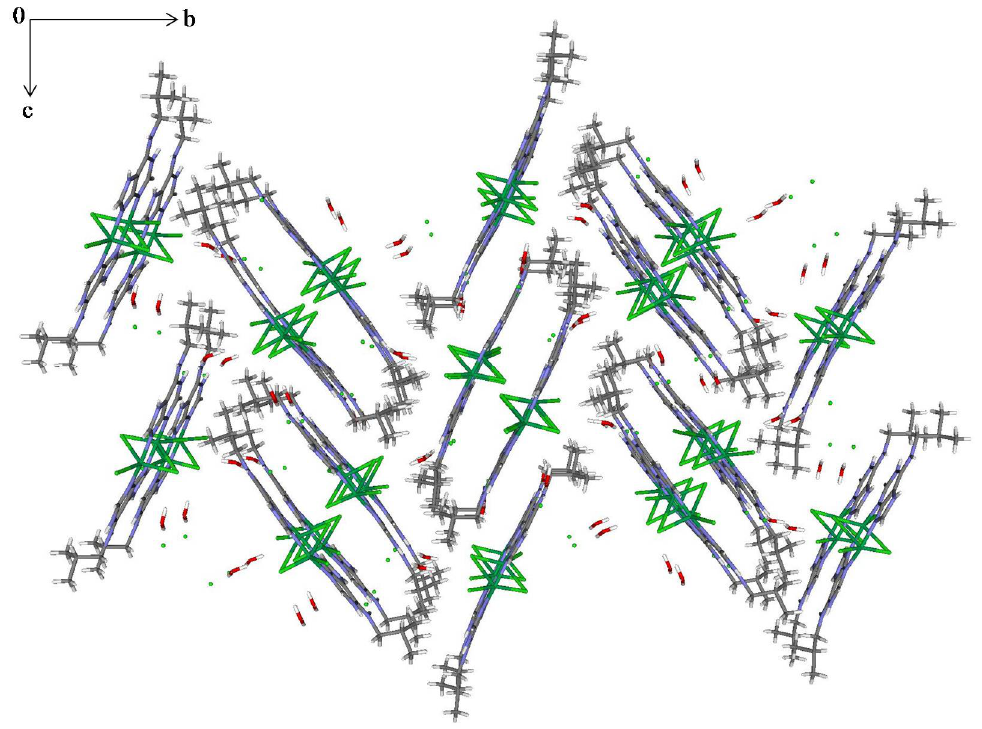
Figure 3. Crystal packing of compound 3 ( bc plane).